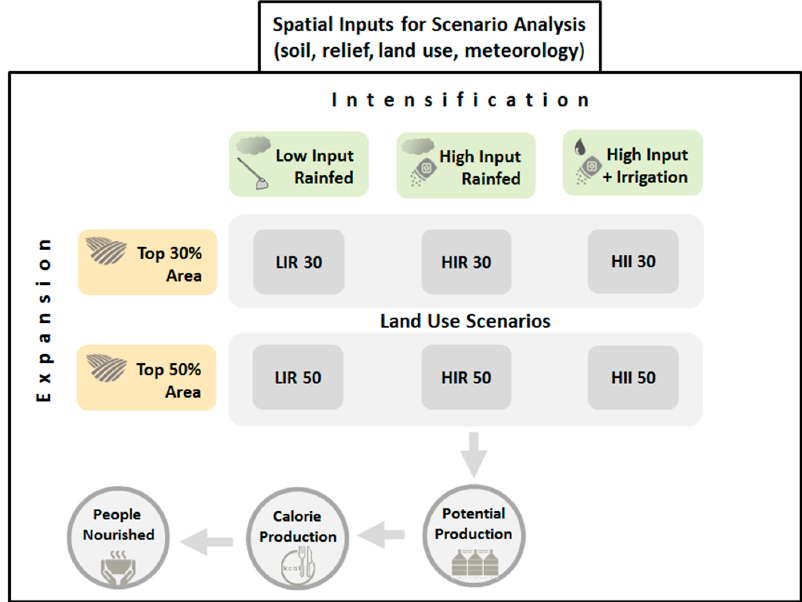
Figure 1. Conceptual framework: Spatial land use scenarios based on assumptions for expansion (brown boxes) and intensification (green boxes). Derived outputs are potential crop- and calorie production and number of people nourished. The scenarios are simulated and analysed spatially, based on spatial information on soil, relief and meteorological drivers.